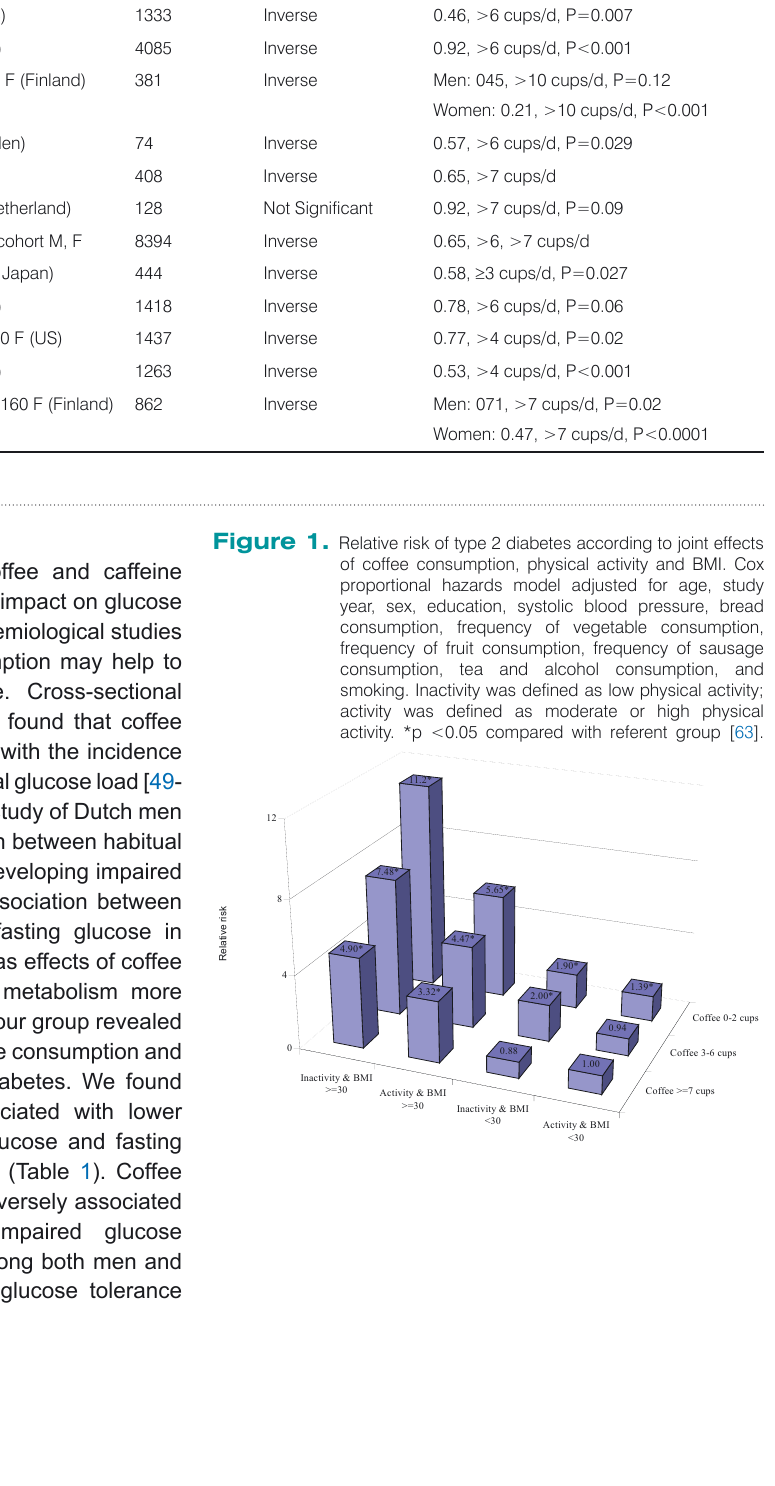
Table 3. Cohort studies of coffee consumption and risk of type 2 diabetes [ 63 ].